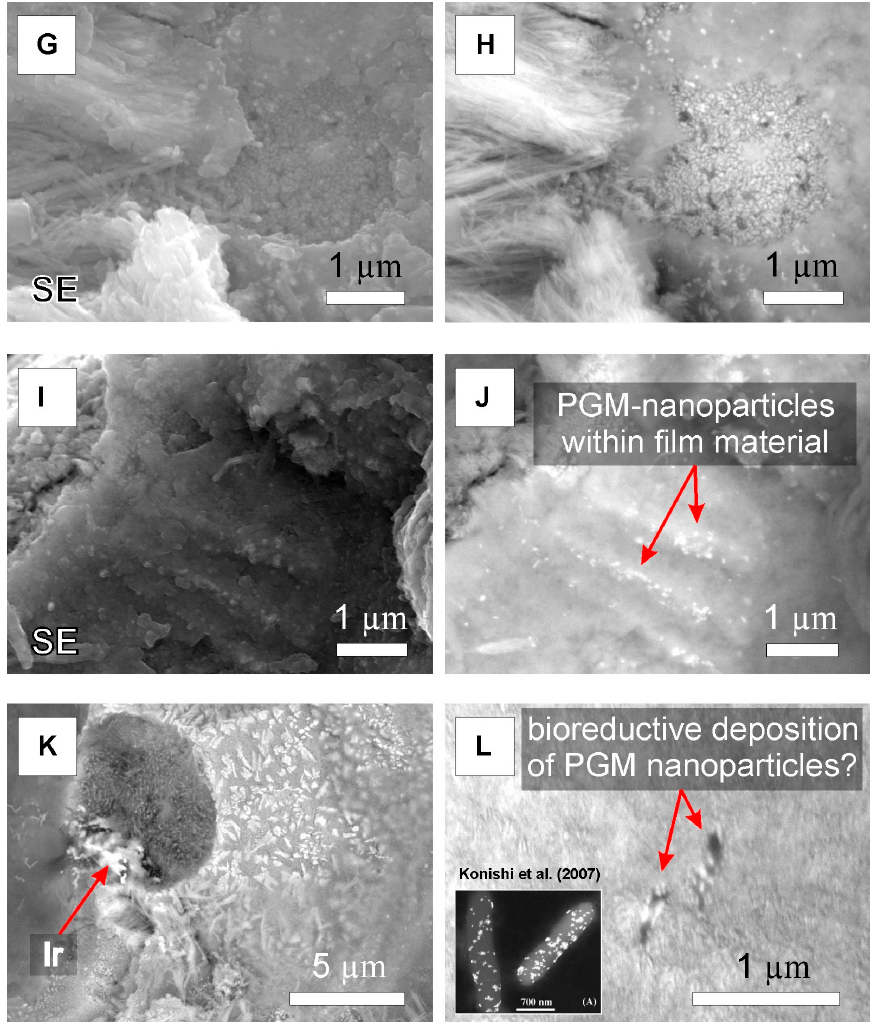
Figure 3. BSE and secondary electron images (SE) of a fibrous PGM showing numerous